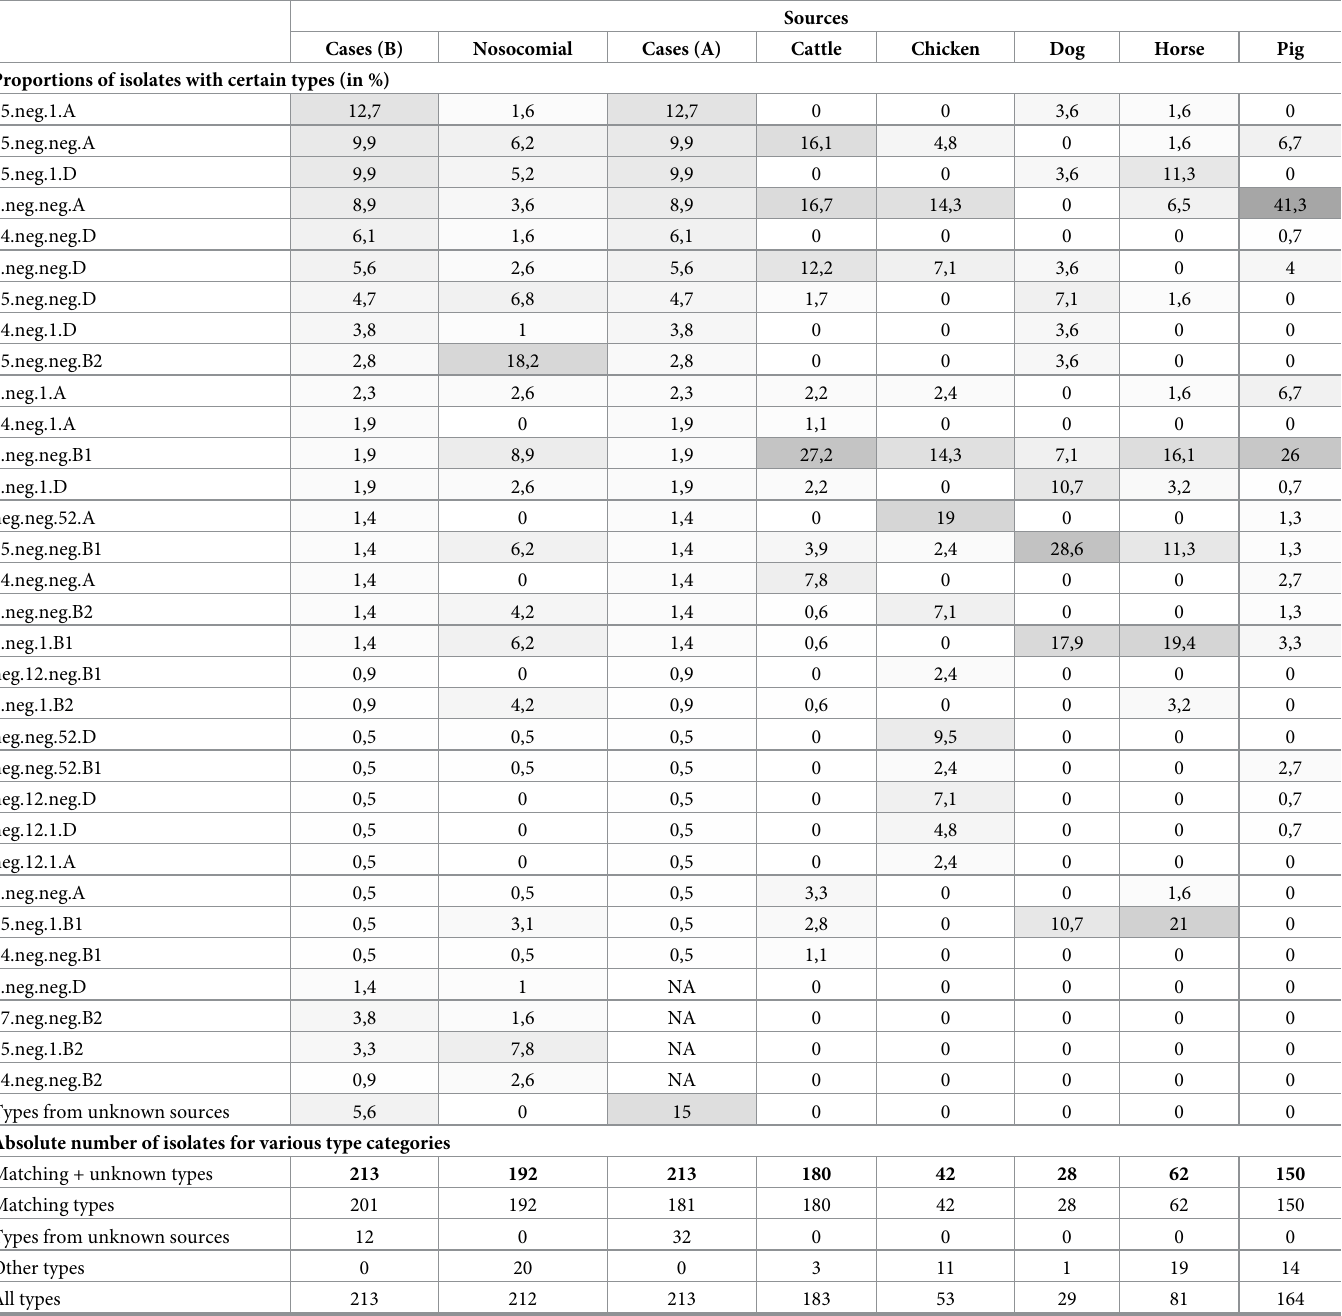
Table 4. Number of matching, unknown and other types for Set A2 and B2. Sources Cases (B) Nosocomial Cases (A) Cattle Chicken Dog Horse